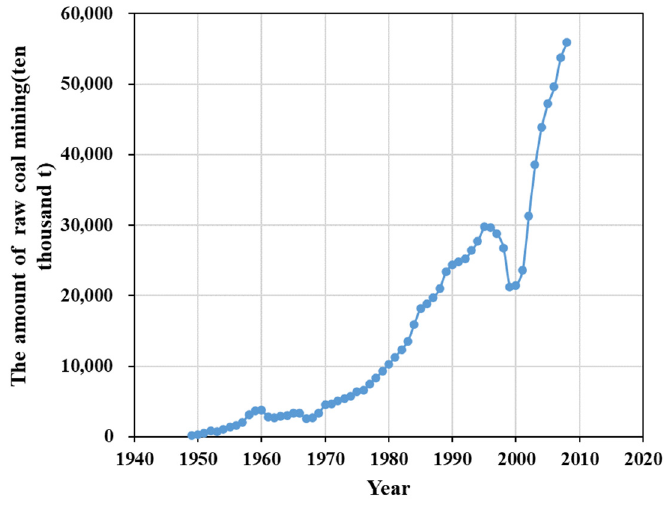
Figure 2. The amount of raw coal mined in Shanxi Province (1949–2008).